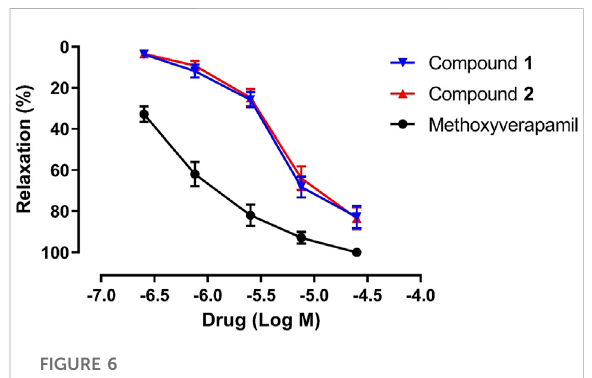
FIGURE 6 Vasorelaxant effects of compounds 1 , 2 , and methoxyverapamil on rat aortic rings pre-contracted with KCl ( n =